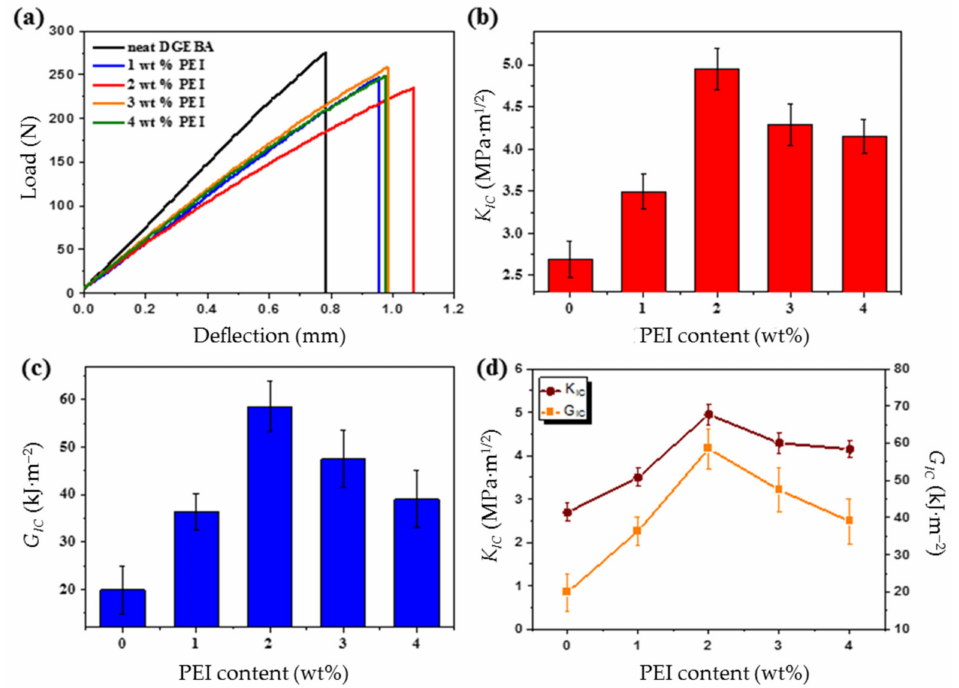
Figure 6. Fracture toughness behaviors of the DGEBA/PEI blends: ( a ) load–deflection curves, ( b ) K IC , ( c ) G IC , and ( d ) correlations between the K IC and G IC